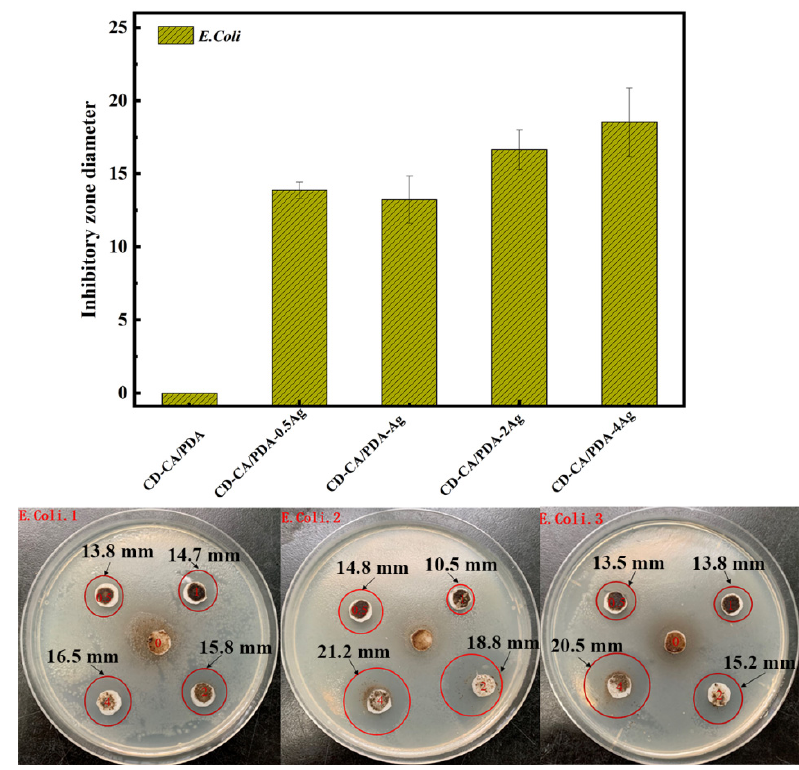
Figure 8. Diffusion inhibition zone of CD-CA/PDA and CD-CA/PDA-xAg to E. coli .